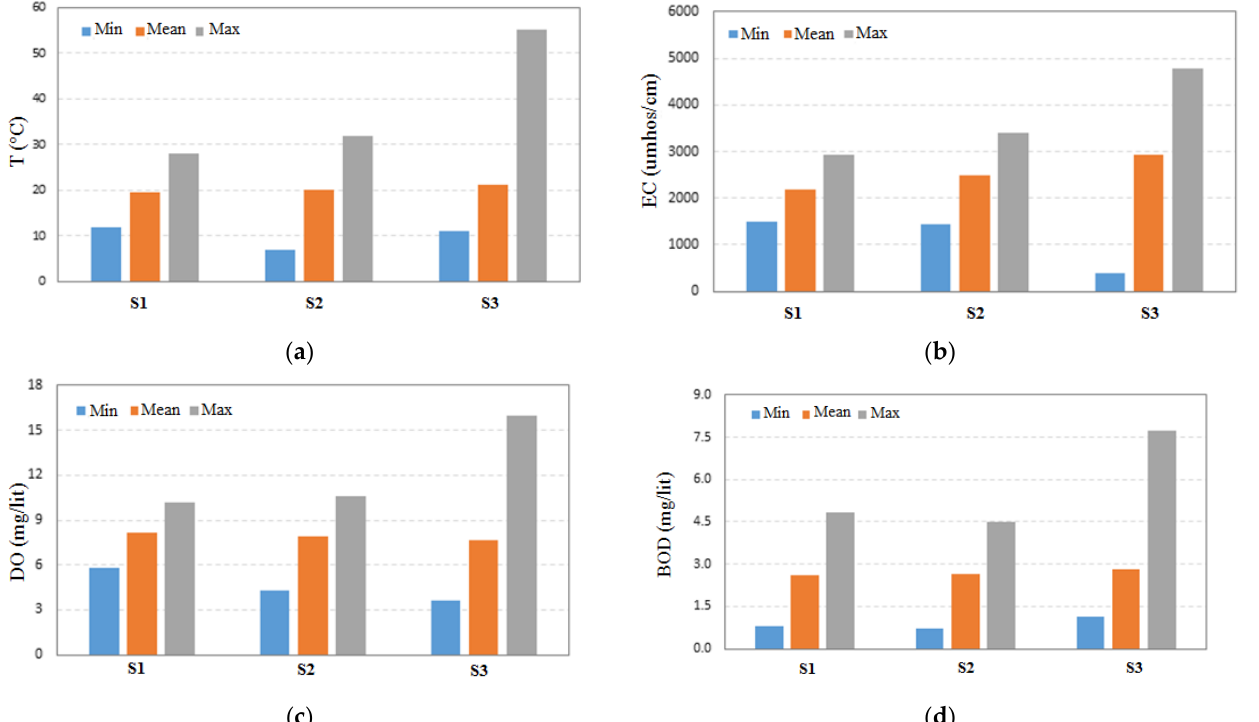
Figure 8. Example water quality parameters: ( a ) temperature (T); ( b ) electric conductivity (EC); ( c ) dissolved oxygen (DO); and ( d ) five-day biochemical oxygen demand monitored at the Maroon and Jarahi river water quality monitoring stations.